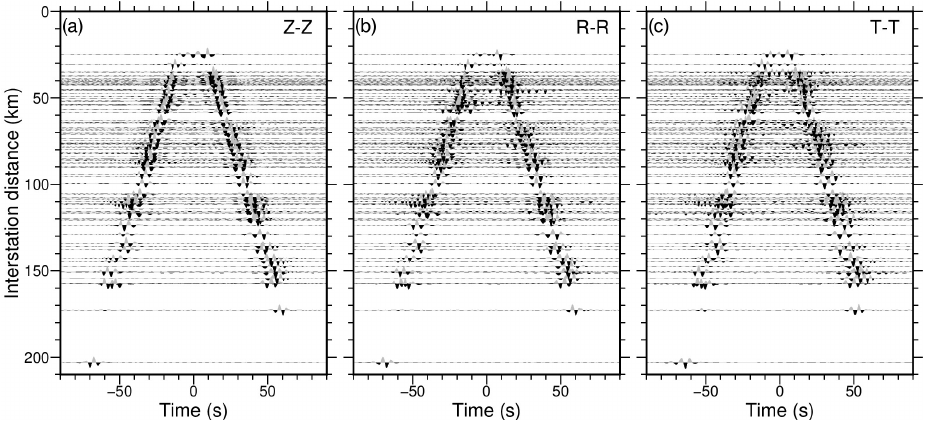
Figure 3. Record sections showing the EGFs of all the available station pairs obtained from the cross-correlation of the (a) vertical ( Z - Z ), (b) radial ( R - R ), and (c) transverse ( T - T )